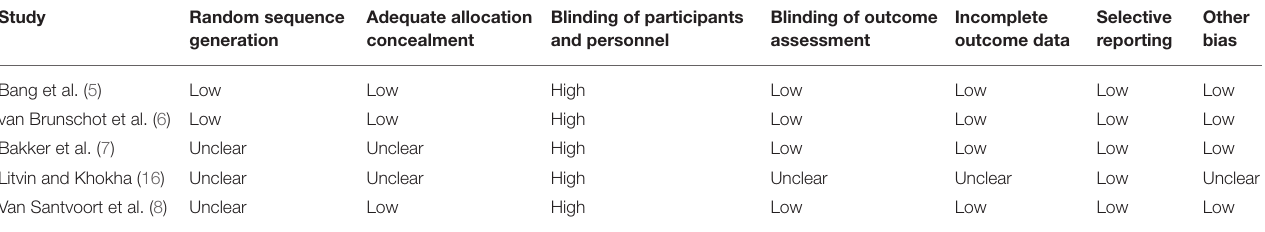
TABLE 3 | Assessment of risk of bias of included